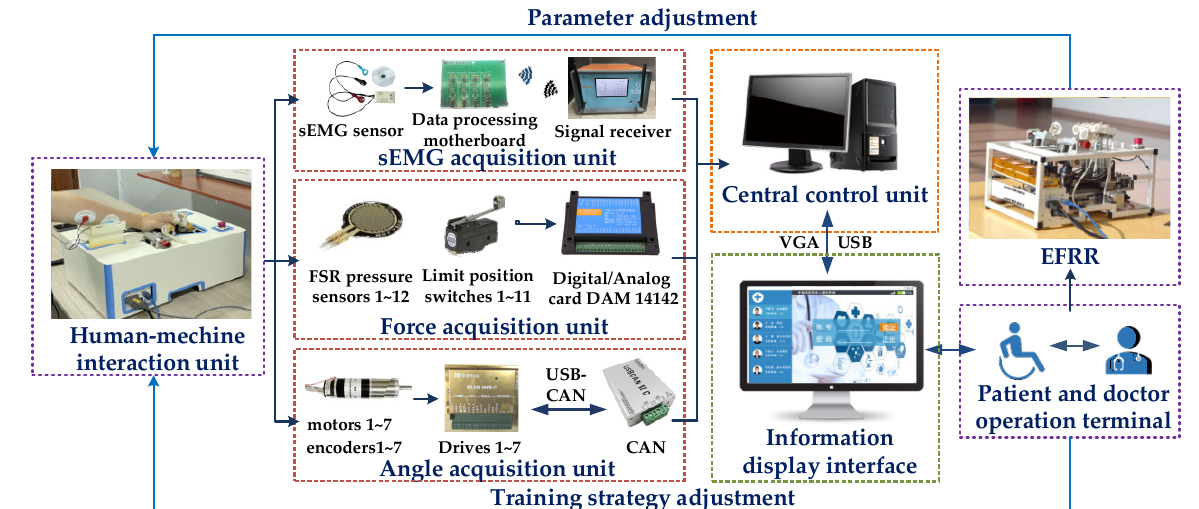
Figure 3. Functional block diagram of EFRR.